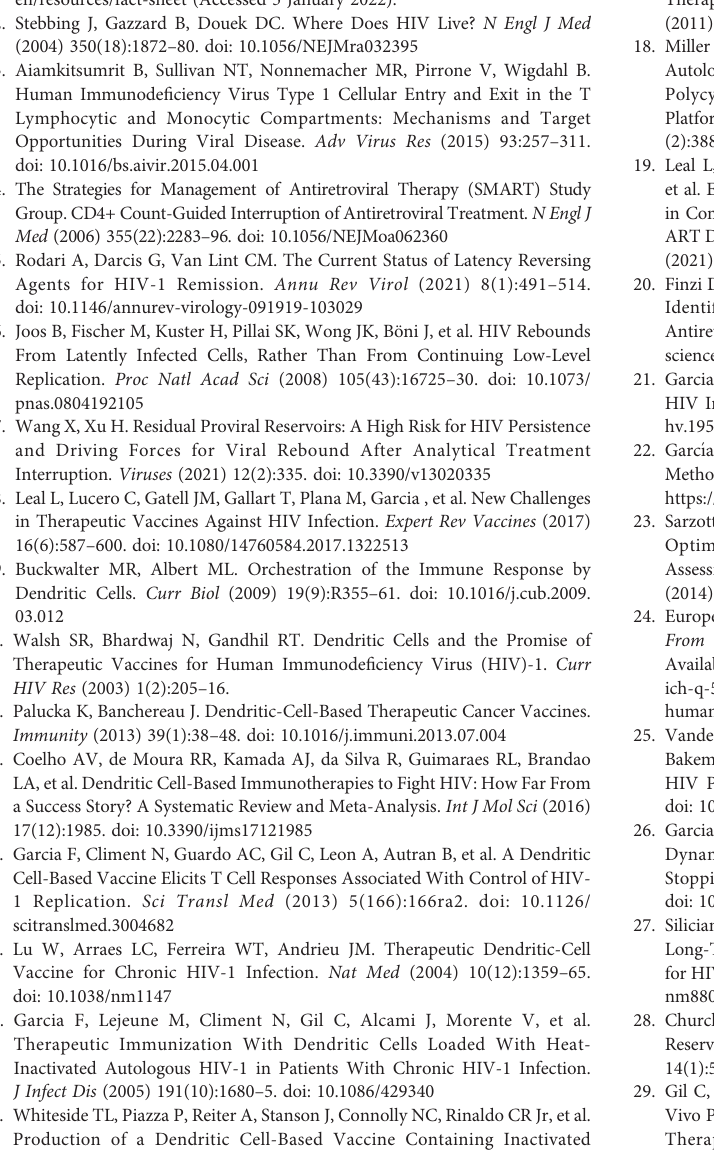
Supplementary Figure 2 | AnalysisoftheassociationbetweenVLHIVRNA(copies/ mL) and amount of HIV p24 Antigen (ng/mL). HIV RNA and p24 antigen obtained from mixing supernatants collected after 7 and 14 days in the same coculture. Supplementary Table 1 | Summary of alternative methods for immunogen production for anti-HIV vaccines. The method reported for primary quantitation of viral yield (vRNA copies/mL, viral particles/mL,orHIV p24 ng/mL) is indicatedin boldwhile to enable comparisions the corresponding values for the other parameters are also estimated, based on 2 vRNA copies/virion and 10 7 virions/ng p24.